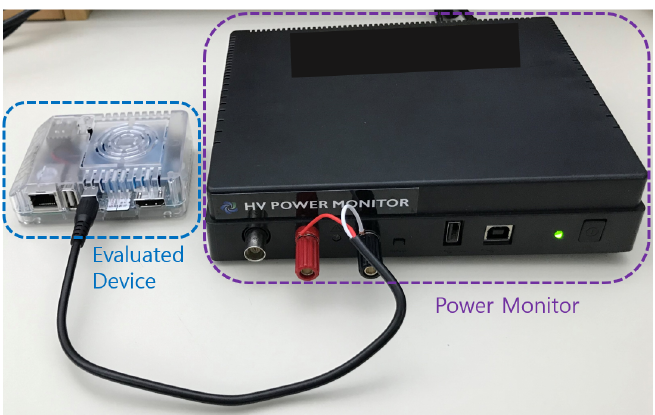
Figure 4. Evaluated ODROID-XU4 and high voltage power monitor (HVPM) to measure energy con-